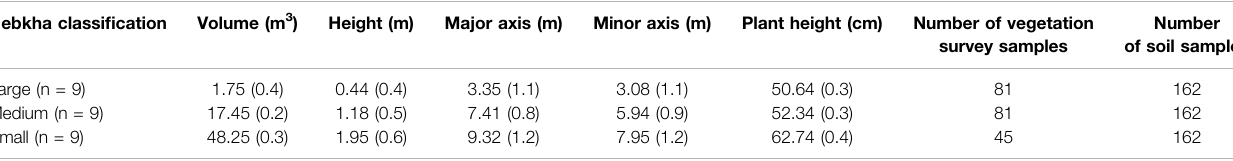
TABLE 2 | Characteristics of the nebkhas measured in this studya.